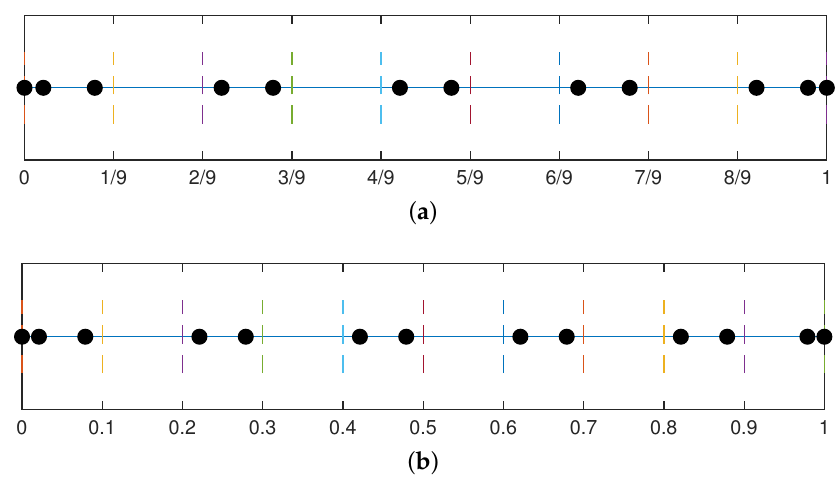
Figure 8. CSC points ( p = 3). ( a ) Odd number of elements. ( b ) Even number of elements.